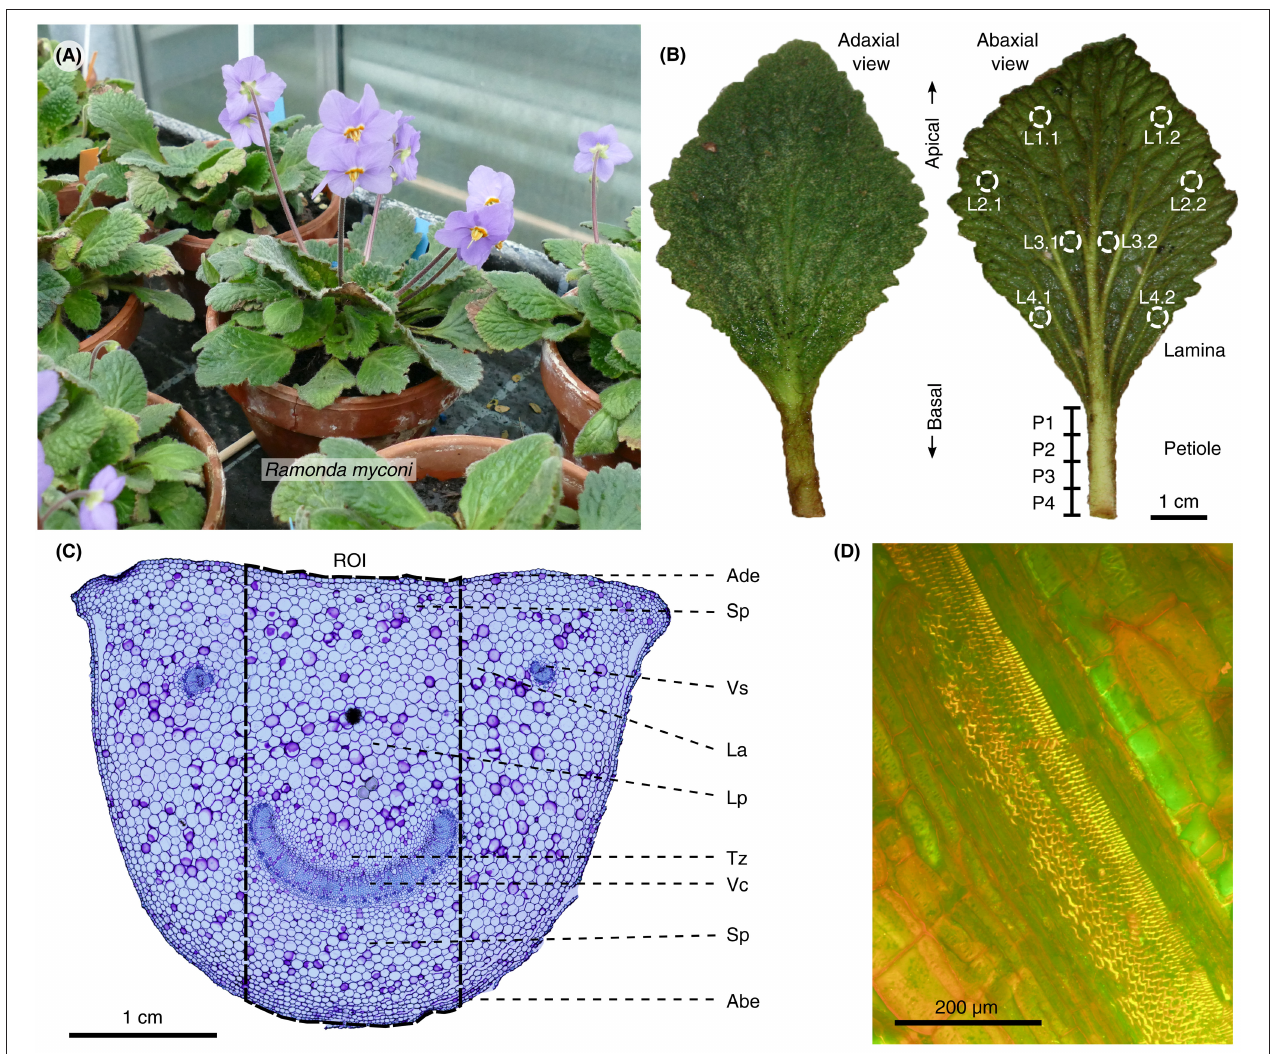
FIGURE 1 | Habitus, leaf morphology and anatomy of R. myconi . (A) Cultivated flowering plants. (B) Adaxial and abaxial view of R. myconi leaves. Sampling areas for the location-specific RWC measurements are marked on the lamina and petiole of the right leaf. L1–L4: apical to basal lamina sampling areas [additional indices indicate locations left (1) or right (2) from the midrib]; P1–P4: apical to basal petiole sampling areas. (C) Cross-section of the petiole of R. myconi stained with TB. The image highlights all tissue types and the ROI used for the anatomical measurements in each thin section. ABE, abaxial epidermis; ADE, adaxial epidermis; LA,